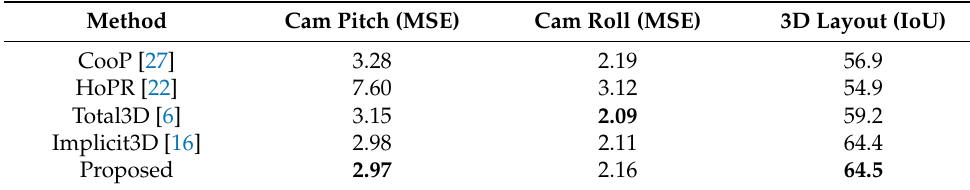
Table 1. Quantitative evaluation results for layout and camera pose estimations. The bolded results represent the highest scores.